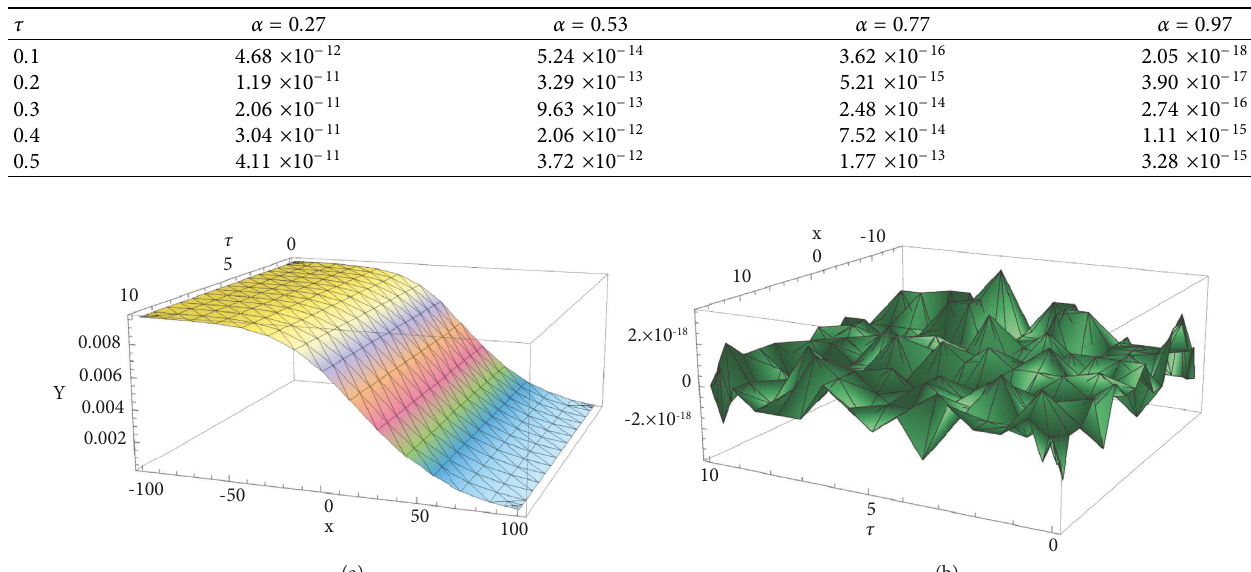
Table 6: He-laplace error in Example 3 at different values of α when ρ � 0.5 and x � 10.